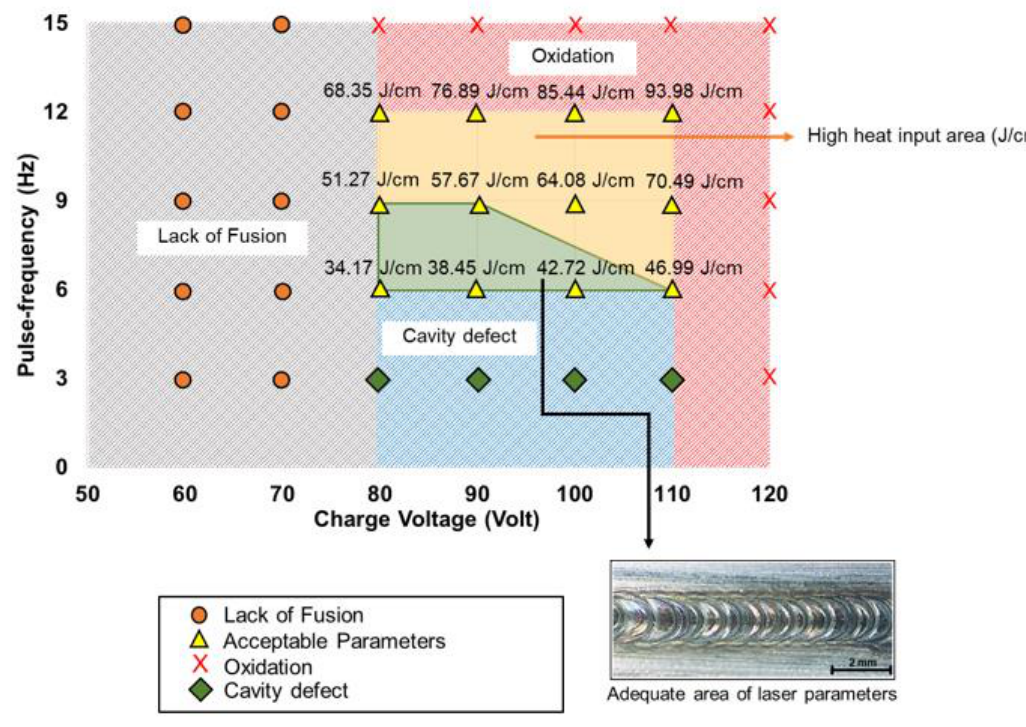
Figure 17. Adequate laser parameters.